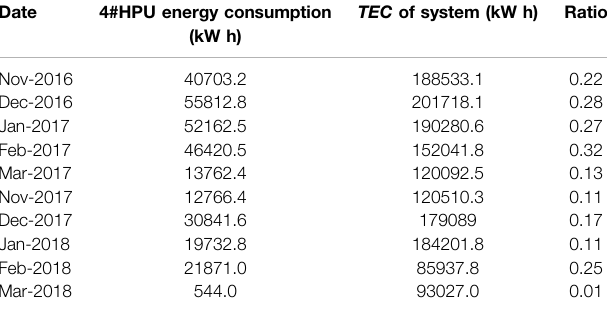
TABLE 2 | 4# HPU energy consumption in the SWC system.